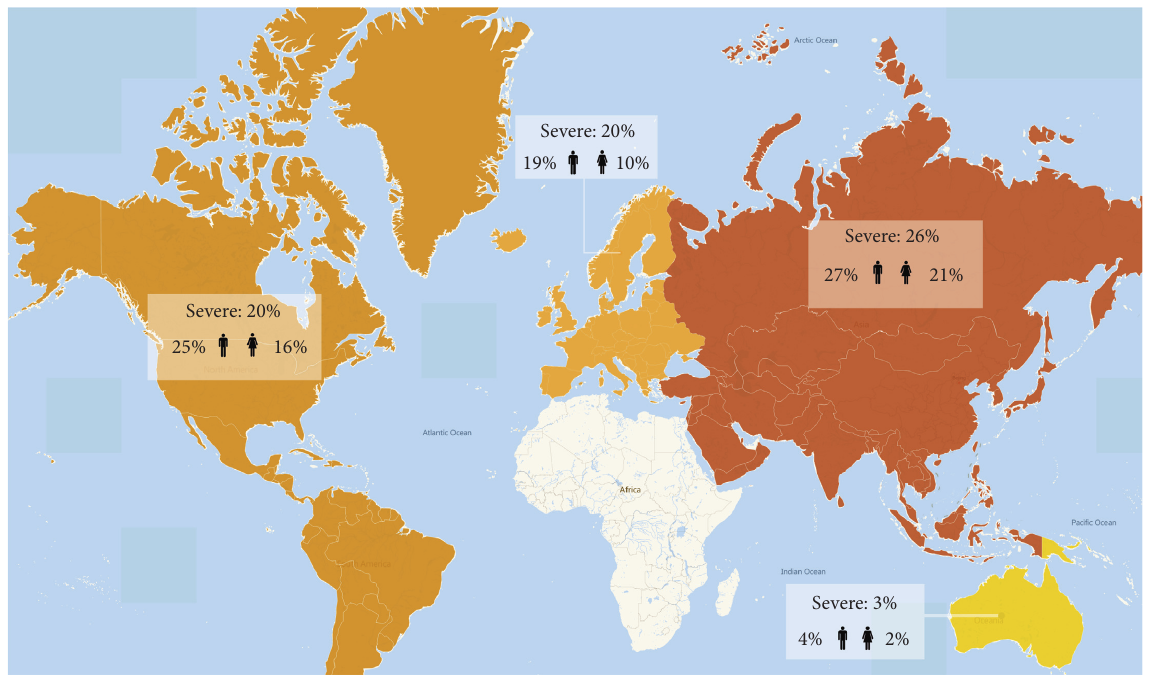
Figure 2: The severity rate of COVID-19 patients in different regions.